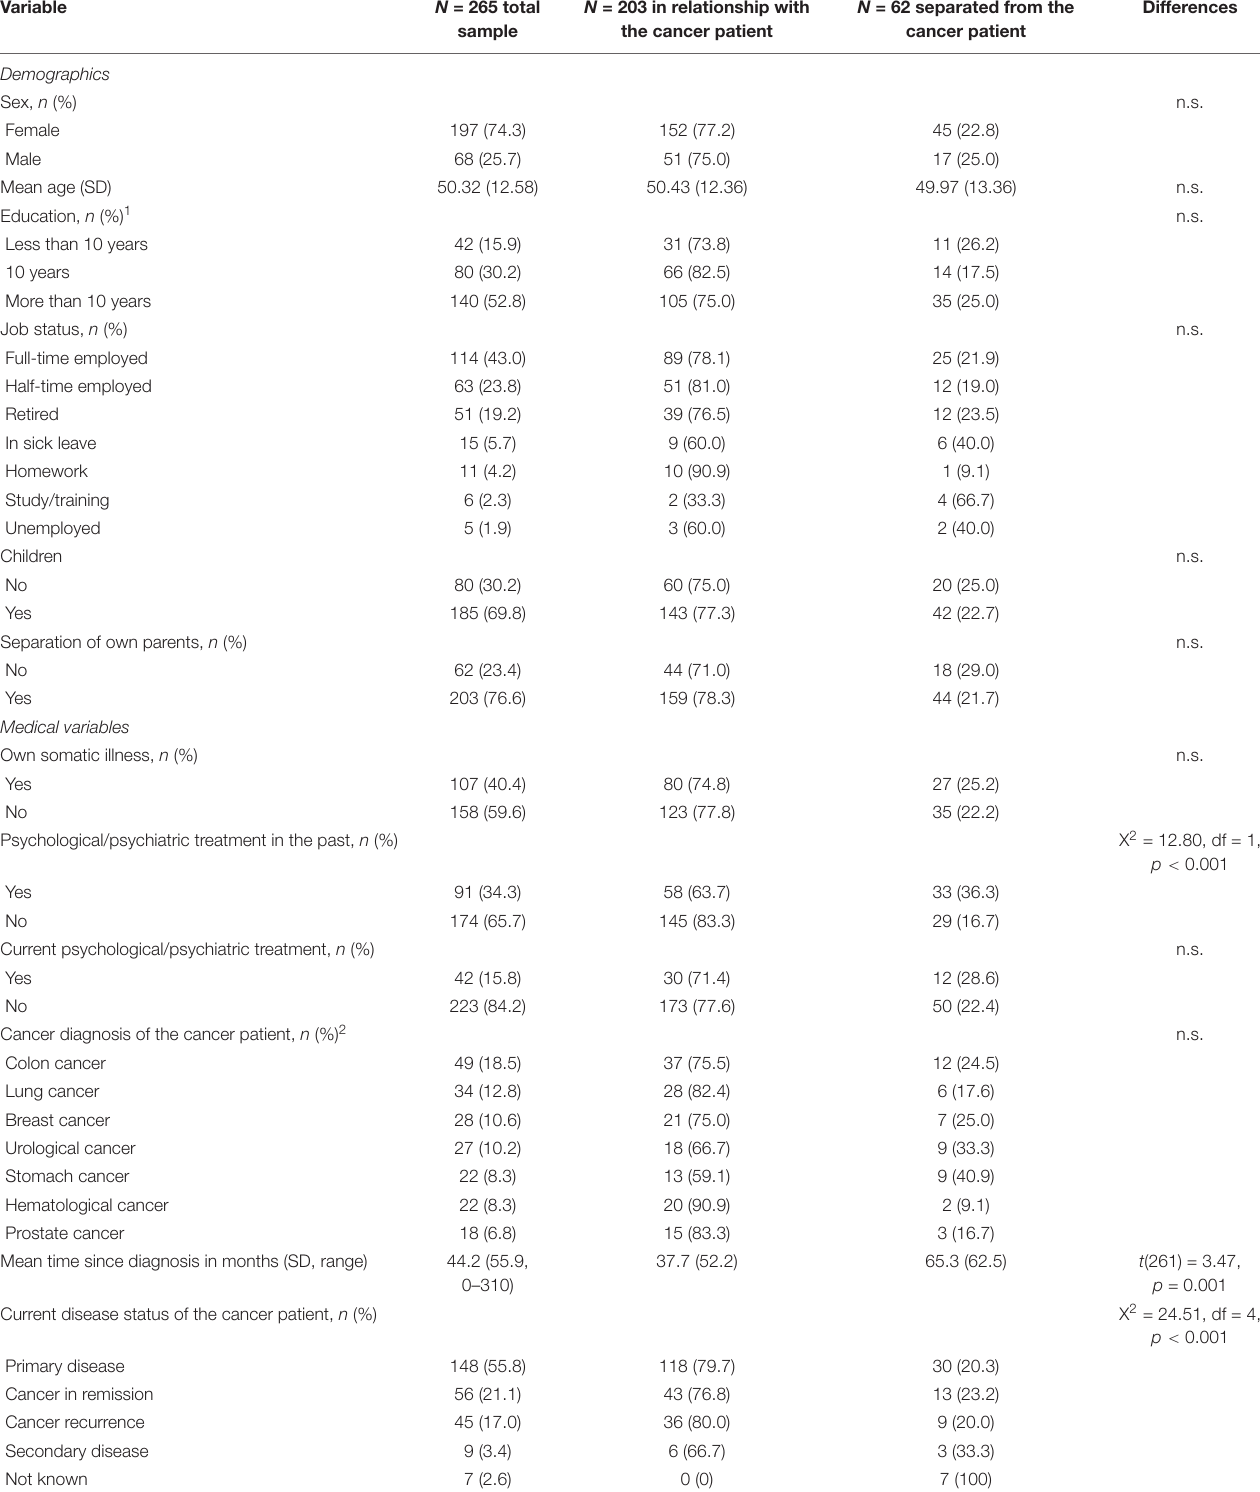
TABLE 1 | Demographics, relationship-related and health-related variables of the total sample ( N = 265) as well as for partners who are in a relationship with the cancer patient at the time of the study ( n = 203) and those who have separated ( n = 62). Variable N = 265 total